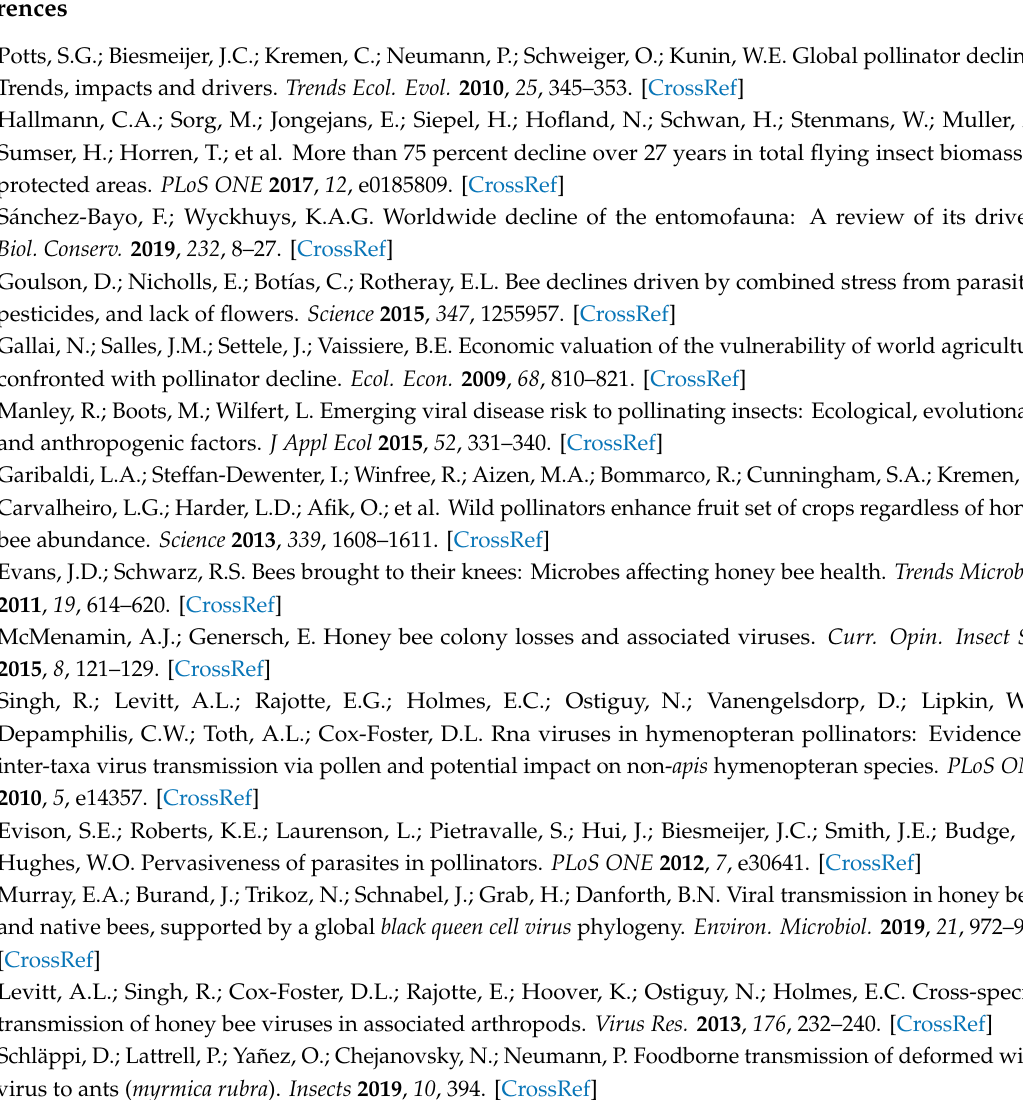
Figure S1: Sampling sites in the far north region near Ahipara, New Zealand, Figure S2: Non-dated phylogeny of Deformed wing virus, Figure S3: Non-dated phylogeny of Kashmir bee virus, Table S1: Primers used for virus detection, Table S2: Sampling location of additional Argentine ant samples used for phylogenetic analyses, Table S3: BaTS analysis of non-dated Deformed wing virus phylogeny, Table S4: BaTS analysis of non-dated Kashmir bee virus